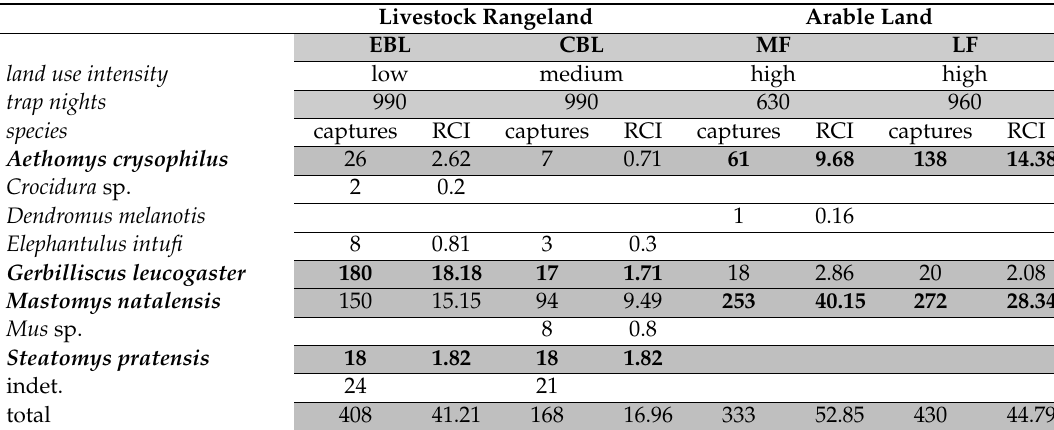
Table 2. Summary of trapping data (total number of captures per species across all trapping sessions) from study sites in Tsumeb agricultural area; changes in species’ capture frequency of ≥ 50% between classes of land use intensity are highlighted in bold; RCI—relative capture index based on number